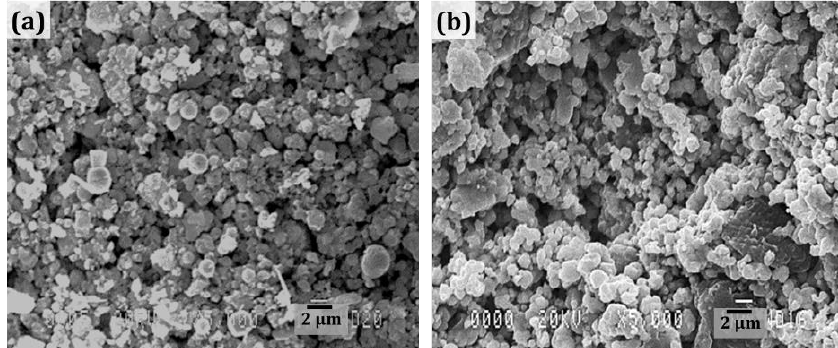
Figure 11. (a) SEM image of the active PZT layer within the Au/PZT/Au/SS sintered by SPS at 850 °C without sintering aid and ( b ) SEM image of screen-printed PZT thick film (900 °C, 2 h, sintering aid) [69].